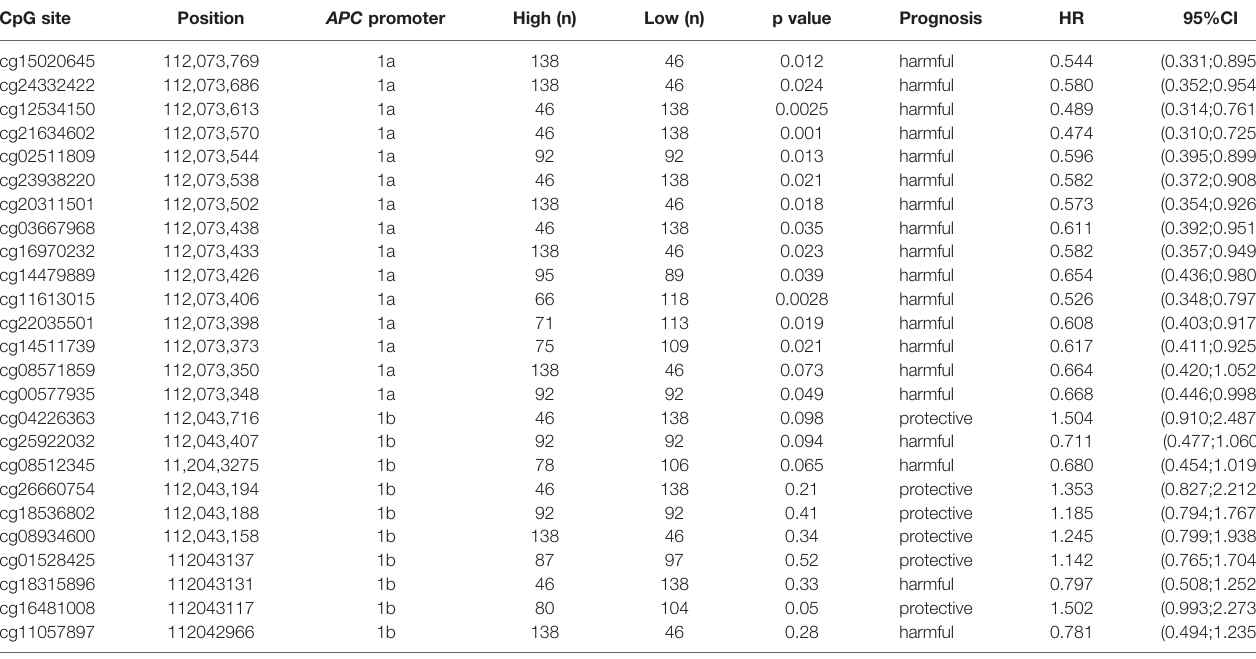
TABLE 2 | Hypermethylation of APC promoters associated with prognosis in pancreatic cancer. CpG